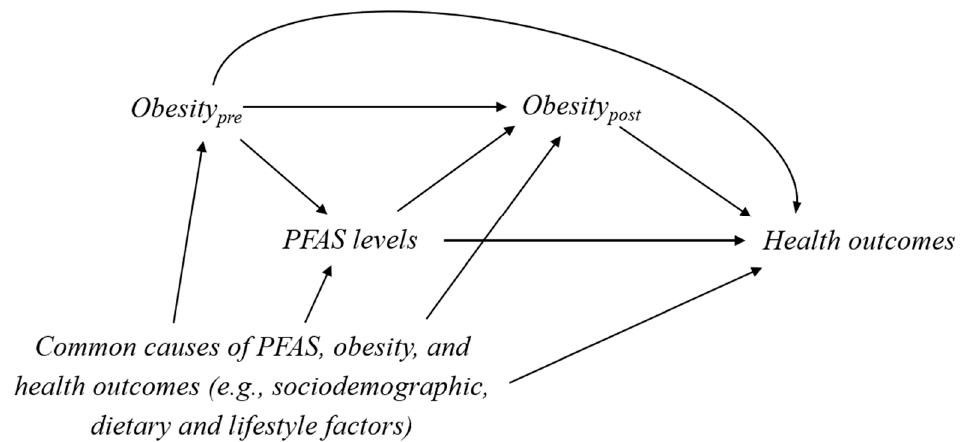
Figure 1. A causal diagram that illustrates the potential causal relationship between PFAS exposure, the measure of obesity, and health outcomes. Obesity pre represents a measure of obesity status before the PFAS measurement and Obesity post represents a measure of obesity after PFAS measurement. Obesity pre affects PFAS levels and health outcomes (i.e., a confounder), while Obesity post is affected by PFAS and affects health outcomes (i.e., a mediator). In this scenario, we should adjust for Obesity pre in addition to other confounding variables such as the common causes of exposure and outcomes to unbiasedly estimate the total effect of PFAS exposure on health outcomes. Adjustment for Obesity post is unnecessary and should be avoided. However, the exact timing for Obesity pre is hard to determine because serum or plasma PFAS levels could represent cumulative exposure. For persistent PFAS compounds, obesity may need to be measured at least a few years ahead of PFAS measurements to be considered as Obesity pre .